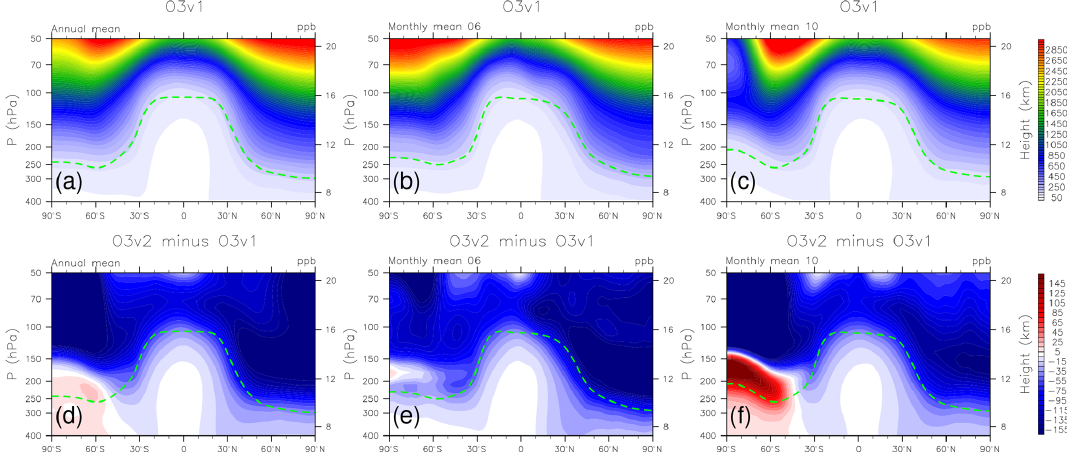
Figure 7. Zonal mean ozone profiles from O3v1 (a, b, c) and O3v2 minus O3v1 (d, e, f) at the upper troposphere and lower stratosphere (UT–LS) region for annual, June, and October